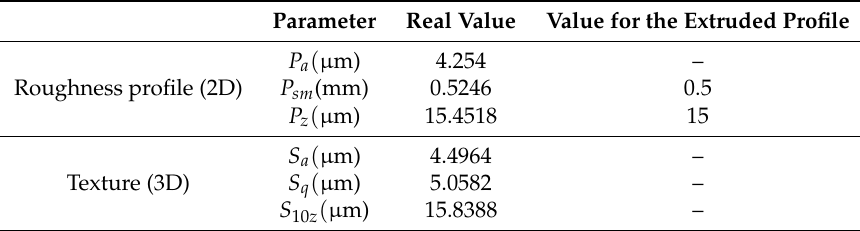
Figure 2. Real roughness profile obtained through ball end milling (discontinuous line) and approximate profile extruded to generate the surface (continuous line). Table 2. Texture ( S ) and 2D roughness profile ( P ) parameters defining the texture implemented in the FEM.